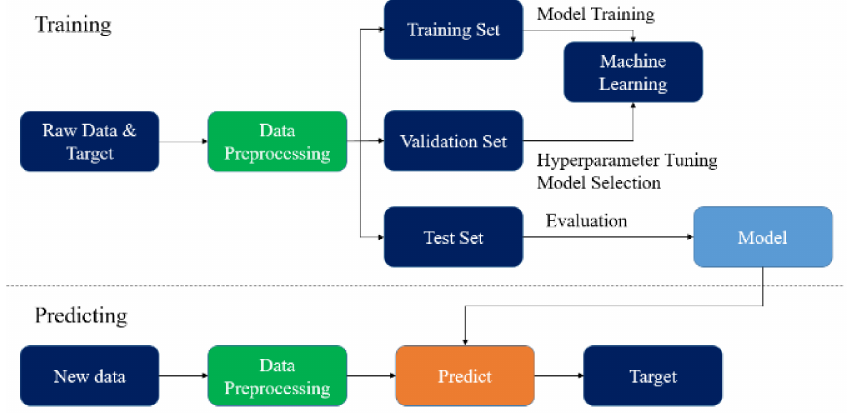
Figure 13. Methodology flow